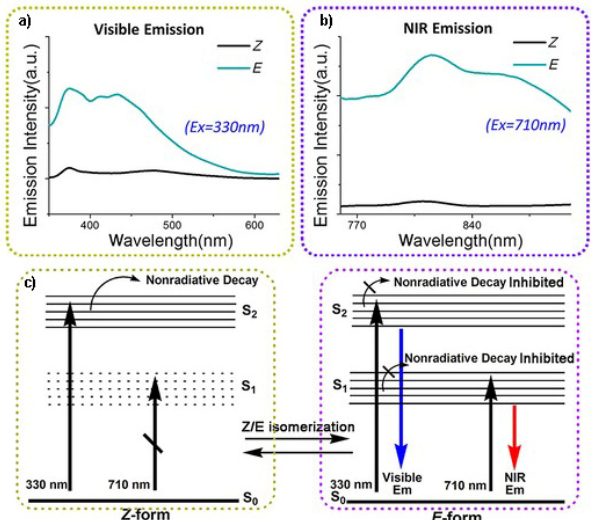
Figure 3. Emission spectra of 3 in Z- and E-form in water (5 × 10 − 5 mol L − 1 ) at RT. ( a ) λ ex = 330 nm, scanning range = 350–900 nm; ( b ) λ ex = 710 nm, scanning range = 730–900 nm. ( c ) Proposed mechanism for the tuning of the dual pathway luminescence in Z- and E-form. Adapted with permission from [37].